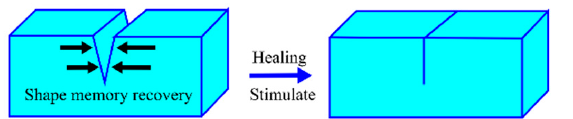
Figure 10. Schematic illustration of the shape memory assisted self-healing process. Before that, the shape fixation rate and recovery rate before and after the addition of O-CNOs were calculated by testing the length of the original sample, the sample stretched to the elongation state, and the sample with shape recovery. The shape fixation rates of R2 and R2-0.5 were ~96% and ~93%, respectively, while their shape recovery rates were ~75% and ~64%, respectively. The addition of O-CNOs slightly led to the decrease of shape fixation and recovery rate of the composites, which may be attributed to the friction resistance produced by